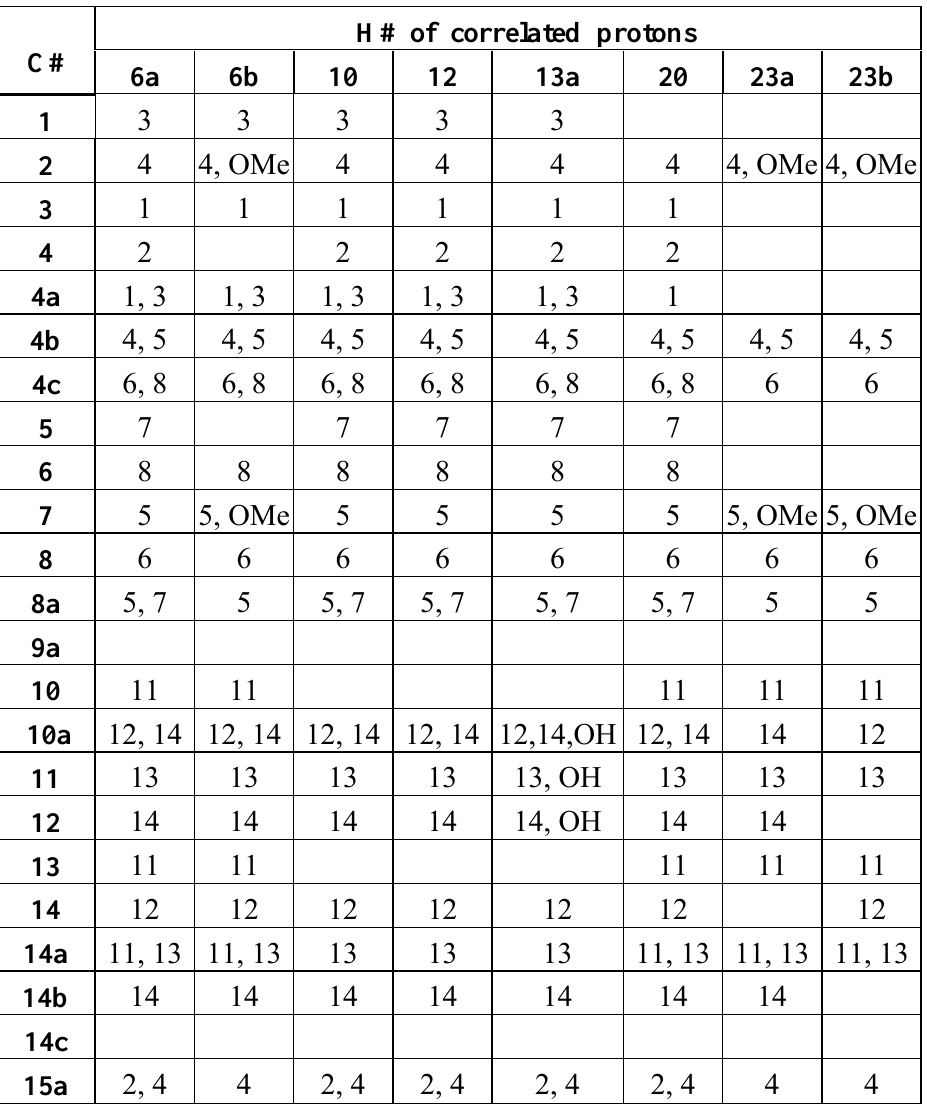
Table 1. Long-range CH correlations observed in the HMBC experiments of the